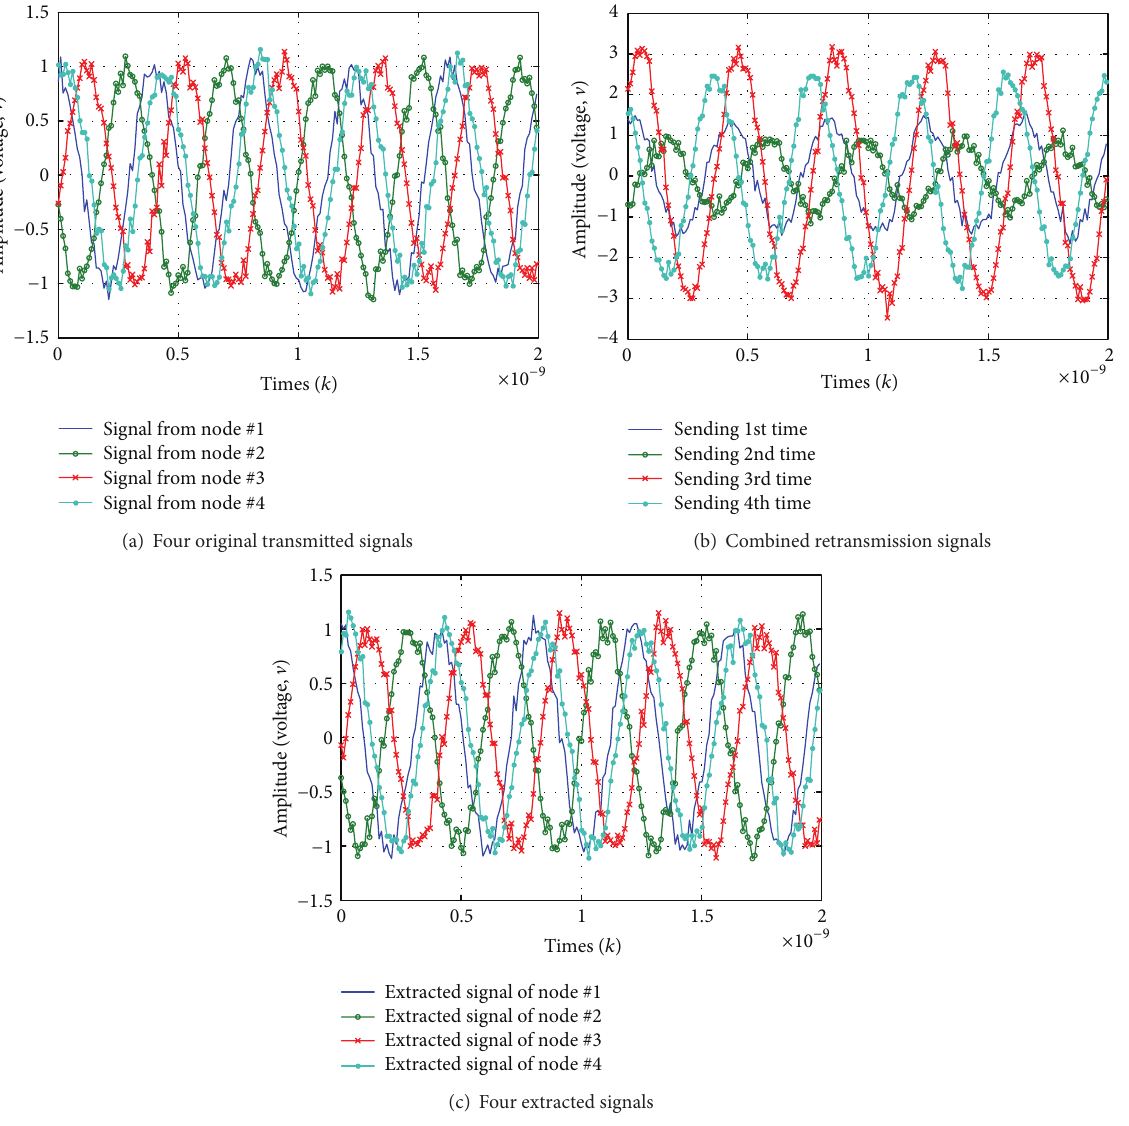
Figure 5: Simulation results from Spatial-Temporal